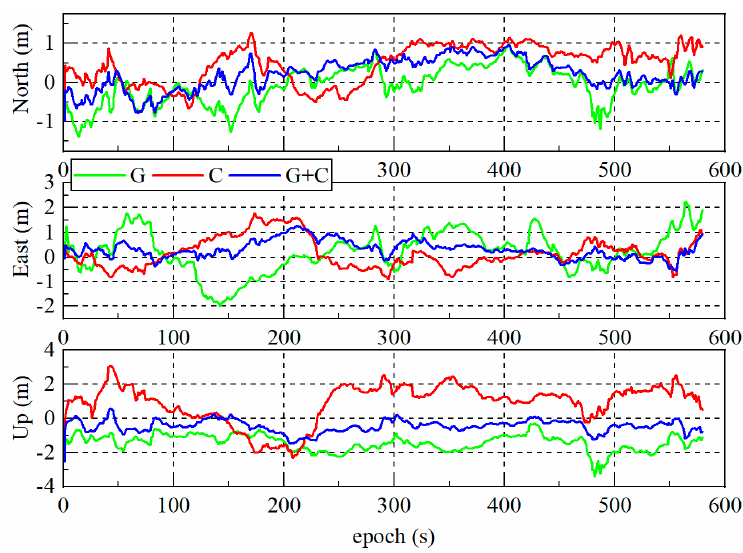
Figure 8. Position error of dual-antenna GNSS/MIMU tightly coupled integration using the SVD- RACKF in the case of single GPS (G), single BDS (C), and their combination (G + C).